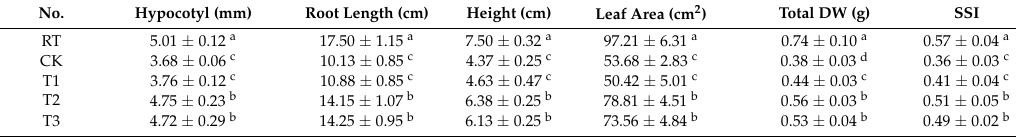
Table 1. Effect of 5-aminolevulinic acid (ALA) on cucumber seedling growth under low-temperature stress. No.